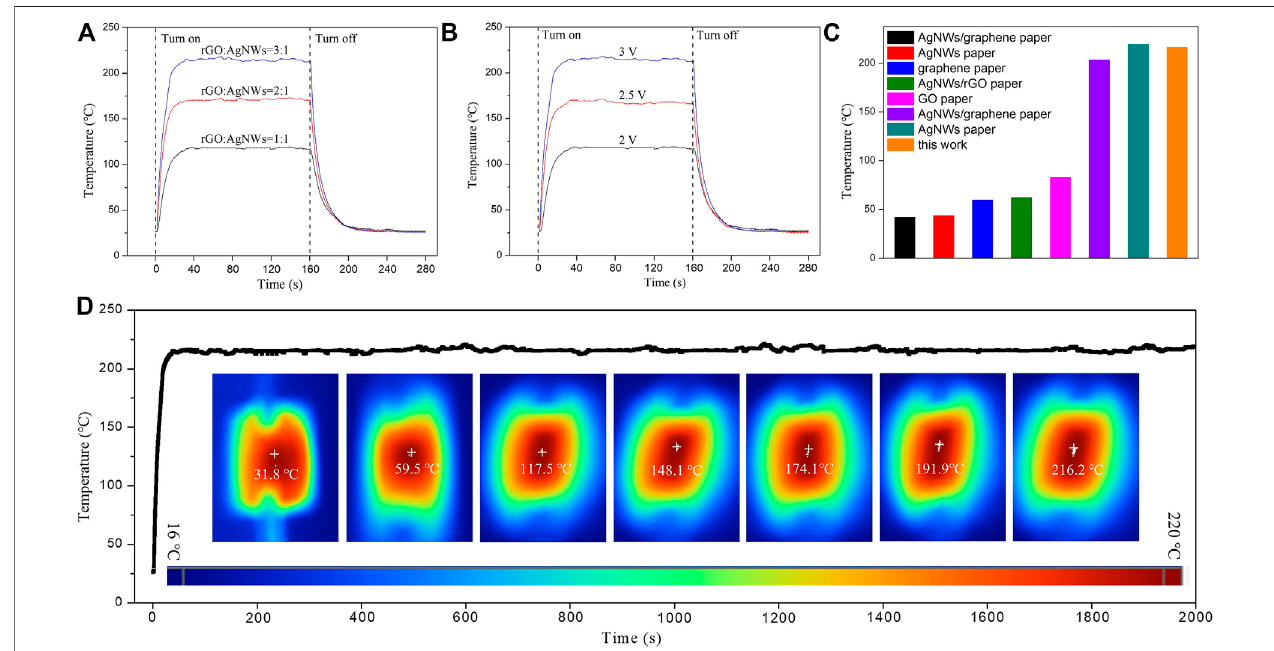
FIGURE 7 | The surface temperature variations of rGO/AgNWs paper with different rGO content versus time at an applied voltage of 2 V (A) , the surface temperature variations of rGO/AgNWs paper versus time at a voltage of 2 V, 2.5 and 3 V (B) , comparison of the Joule heating temperature of as-prepared rGO/AgNWs paper with other composite papers (C) , the time-temperature curve of rGO/AgNWs paper at an applied voltage of 3 V (D) .